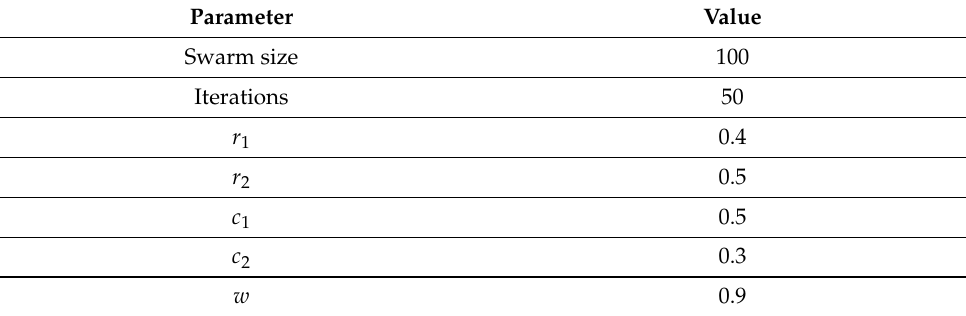
Table 1. PSO algorithm controlling